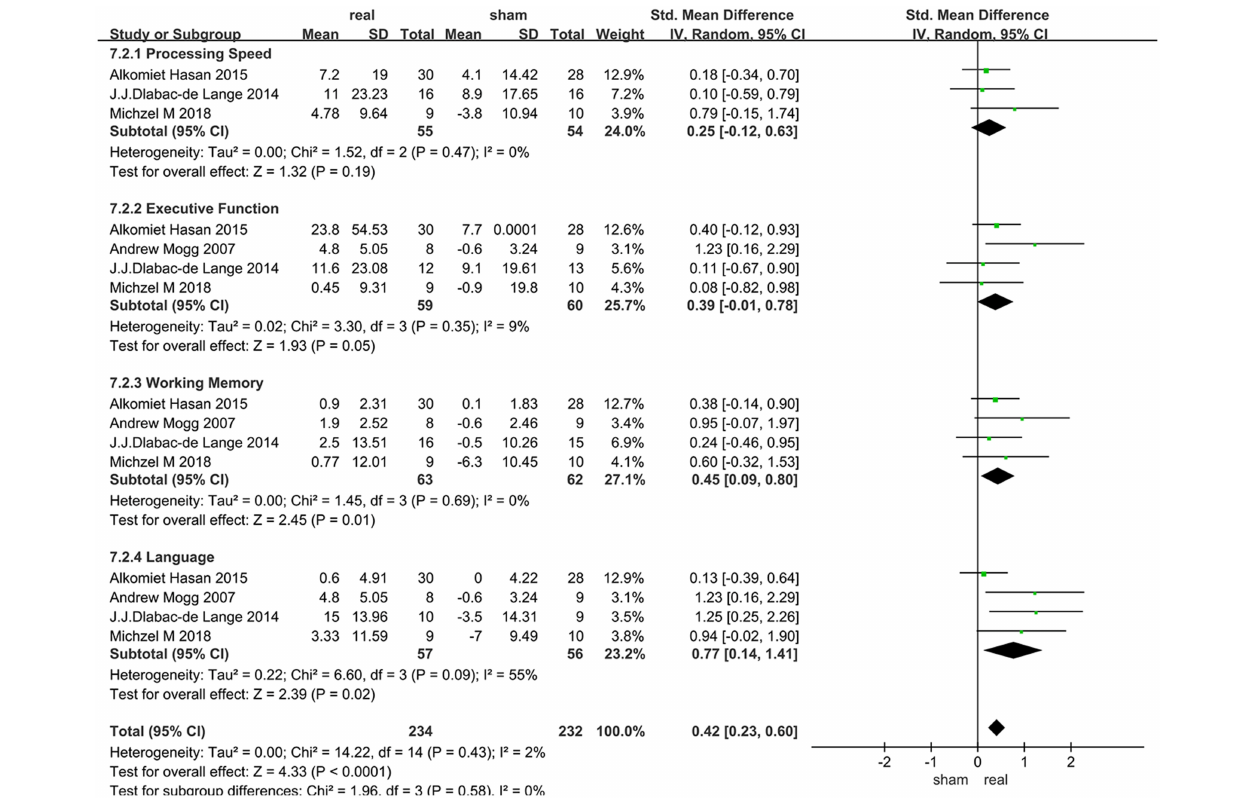
FIGURE 6 | Long-term follow-up efficacy in various cognitive domains after rTMS